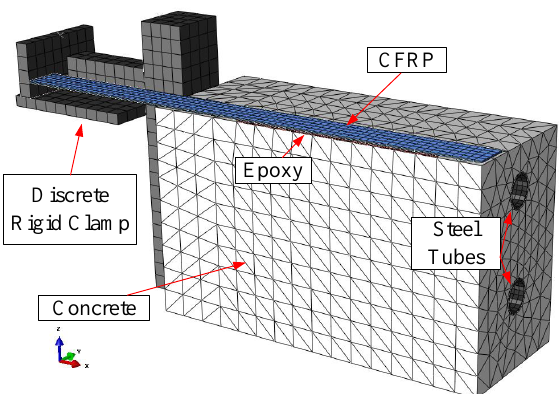
Figure 9. Finite element model constructed in Abaqus to simulate the time-dependent swelling and shrinkage behavior.